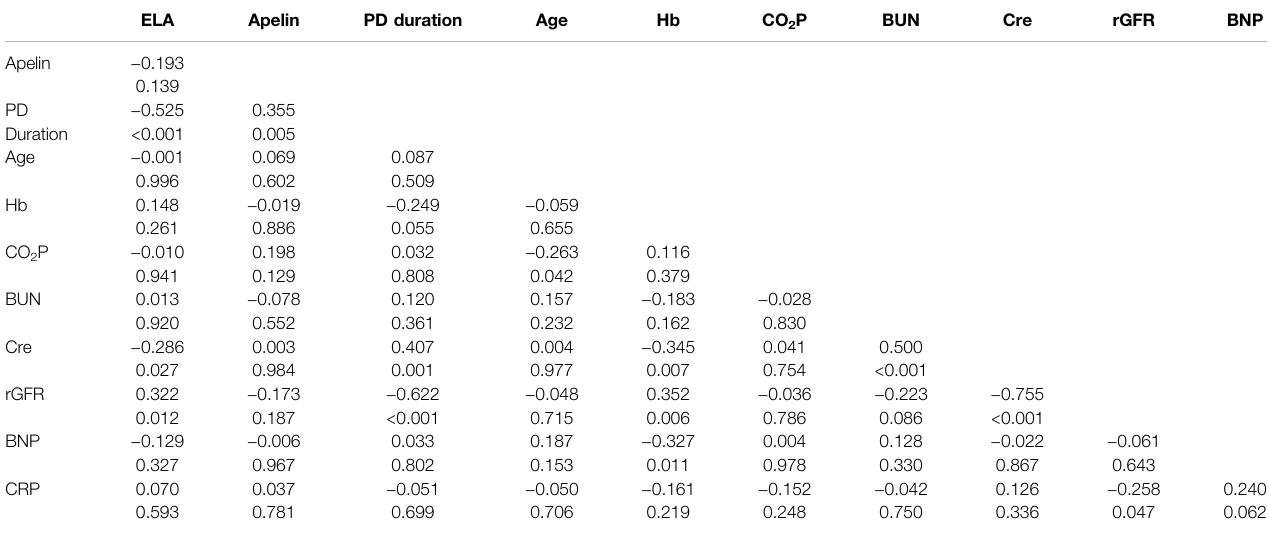
TABLE 2 | R -values and p -values of correlations among the study variables.